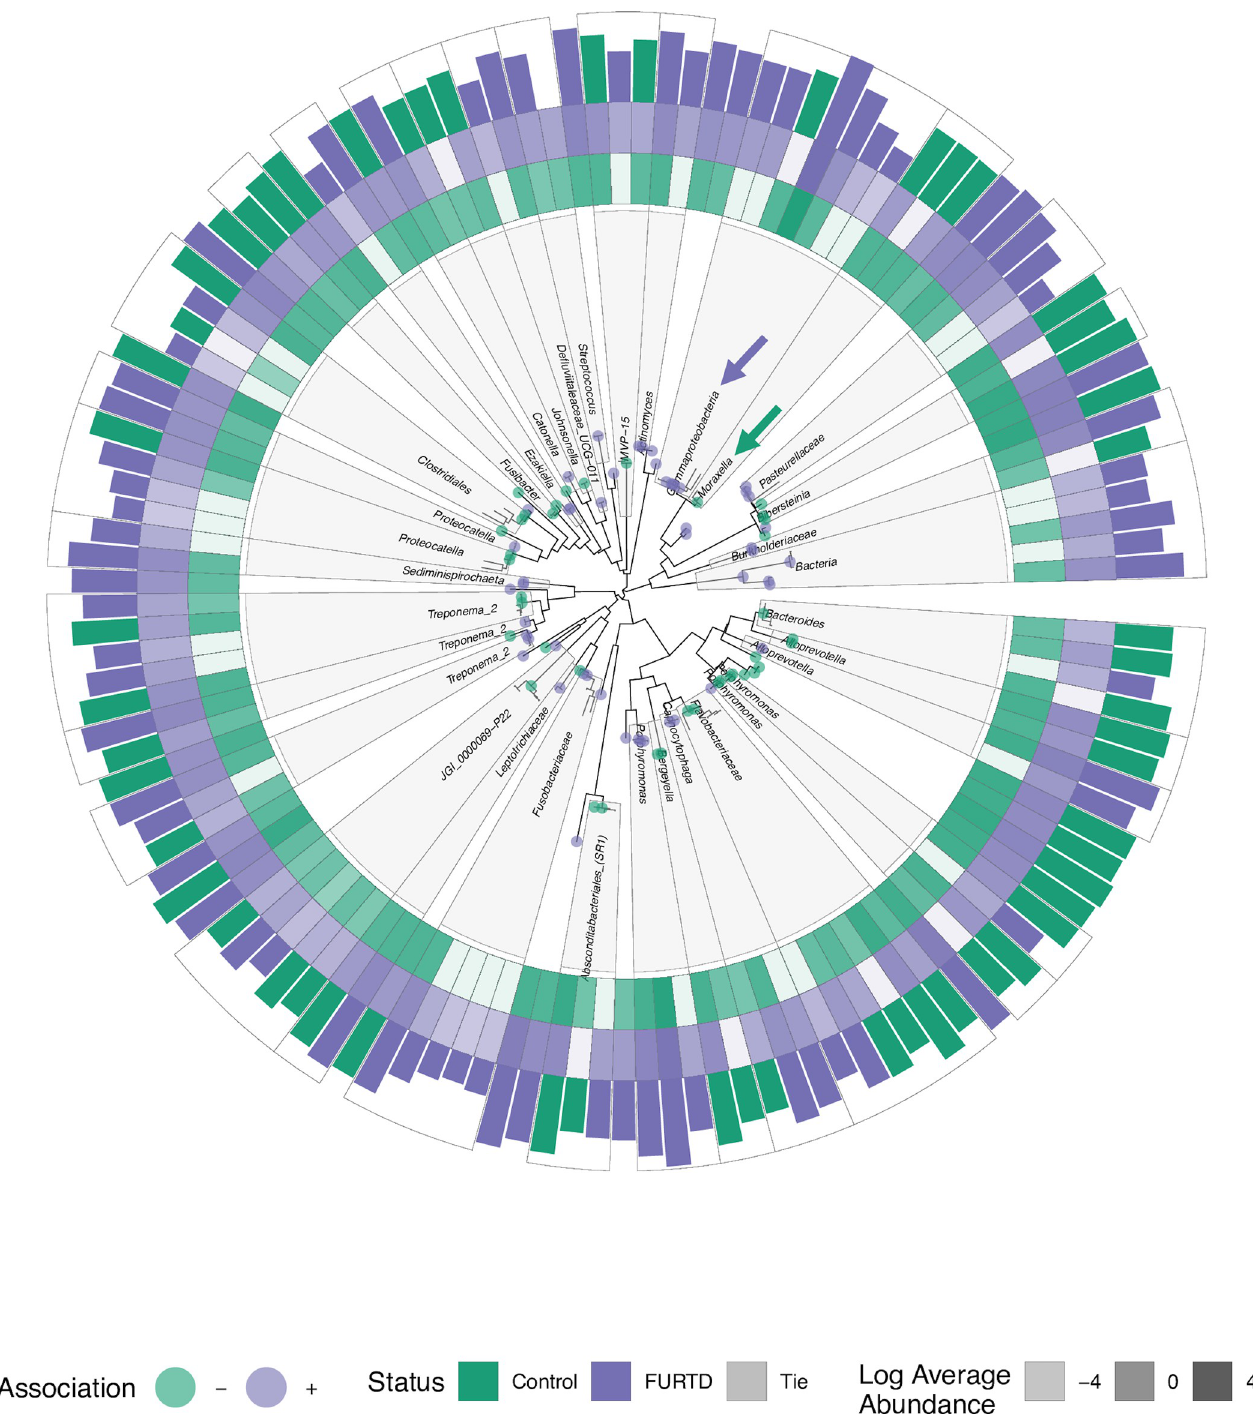
Fig 5. Monophyletic lineages within the nasal microbiome reveal distinct cladal patterns of association with clinical signs. Monophyletic lineages and ASVs within the nasal microbiome significantly associating with clinical signs were subset and visualized. Clade taxonomic labels were assigned by determining the most specific Linnaean taxonomic label that was shared by all cladal descendants. Significant microbial features with FURTD or control individuals are notated on the phylogenetic tree with purple and green points respectively. Tiles represent the log transformed average abundances of each ASV in individuals without ( green tiles , inner ring ) and with ( purple tiles , middle ring ) clinical signs. Bars colors along the outside ring represent the average abundance of the status group with the higher value for that particular ASV. For example, a bar is colored green if cats within the control group had a higher average abundance for that particular ASV compared to FURTD cats. In this example, the bar size would correspond to the average ASV abundance for cats within the control group. Purple and green arrows are referred to as points of interest within the text. https://doi.org/10.1371/journal.pone.0268730.g005 PLOS ONE | https://doi.org/10.1371/journal.pone.0268730 December1,